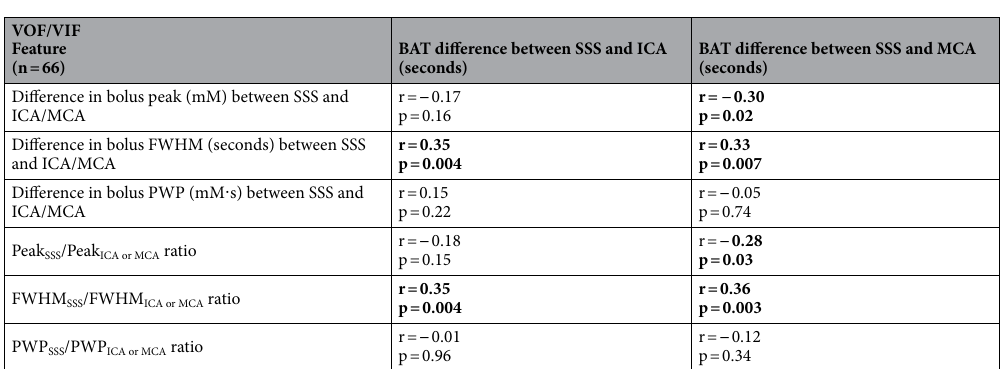
VOF/VIF Feature (n = 66)